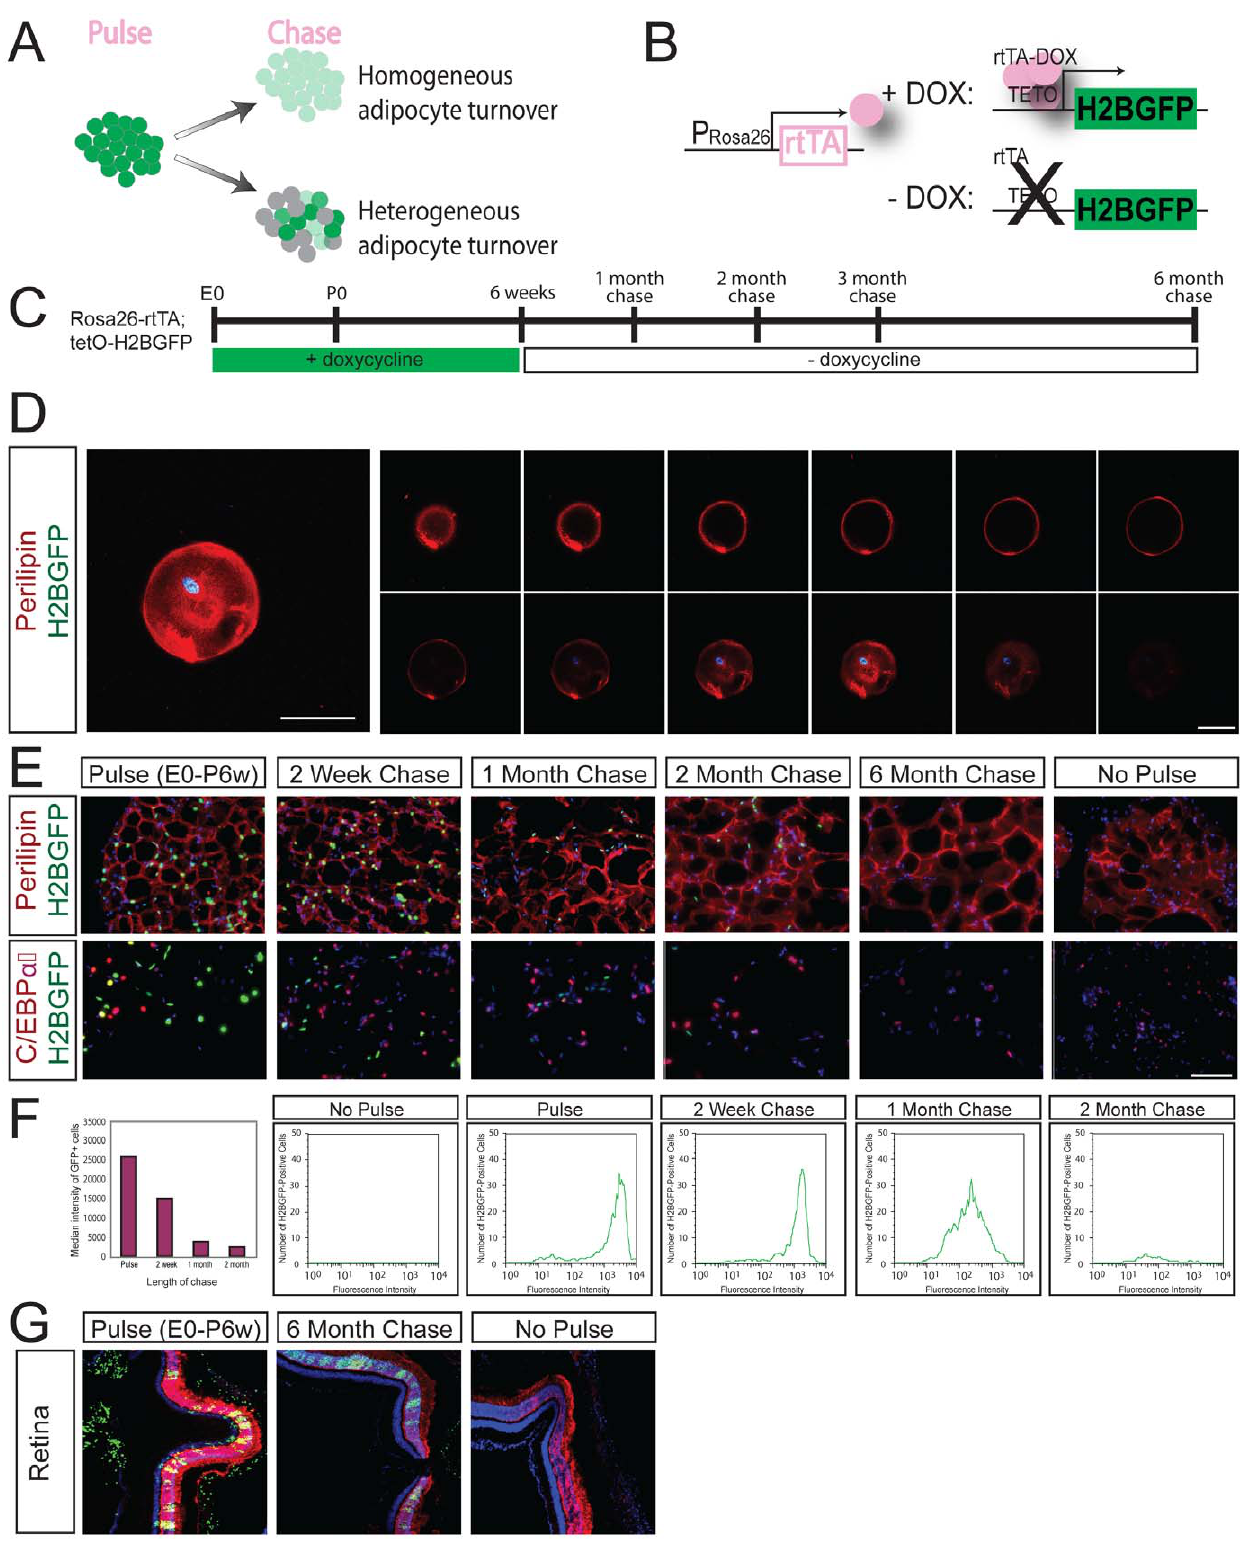
Figure 1. Rapid adipocyte turnover in adipose tissue. A. Schematic showing how Rosa26-rtTA; tetO-H2BGFP pulse-chase dilution can distinguish between homogeneous adipocyte turnover (all adipocytes show loss of H2BGFP florescence) and heterogeneous adipocyte turnover (some adipocytes show loss of H2BGFP florescence, others maintain H2BGFP florescence). B. Experimental schematic for Rosa26-rtTA; tetO-H2BGFP expression. C. Timeline for Rosa26-rtTA; tetO-H2BGFP pulse-chase experiments. D. H2BGFP (green) is detected in the nucleus of single murine adipocytes expressing perilipin (red) and DAPI (blue). Scale bars 50 m m. E. Uniform loss of label in adult adipocytes following pulse-chase with